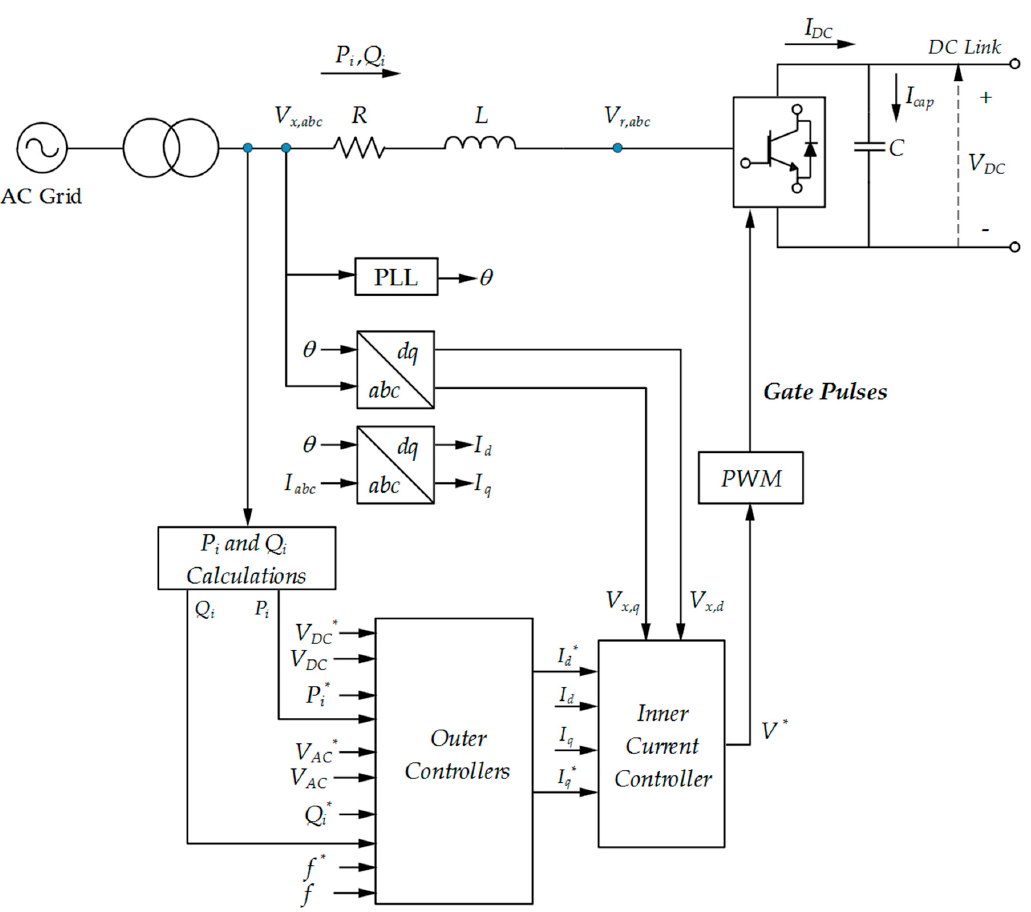
Figure 2. The complete structure of a two-level VSC-HVDC station